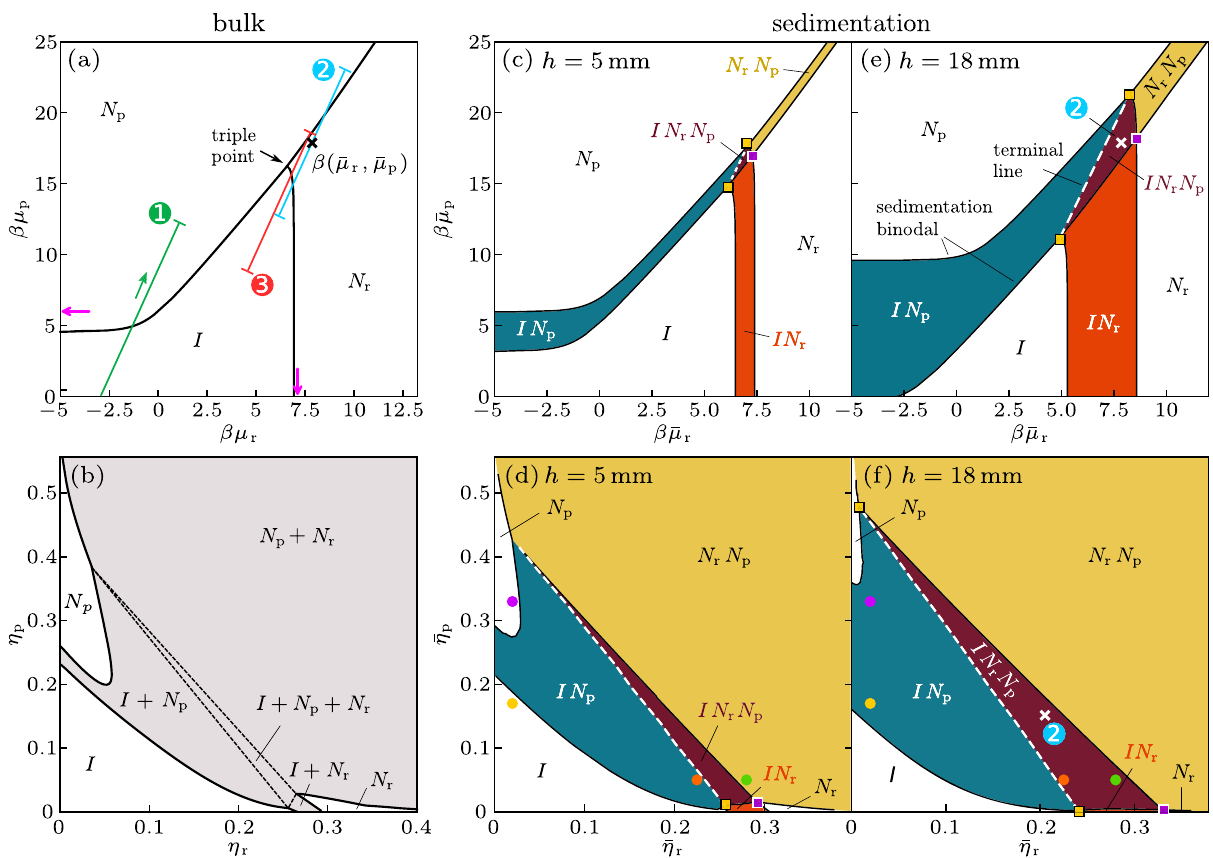
Fig. 4 Bulk and stacking diagrams. Bulk phase diagram in the plane of chemical potentials of rods μ r and plates μ p ( a ) and also in the plane of packing fractions of rods η r and plates η p ( b ). The chemical potentials are scaled with the inverse temperature β = 1/( k B T ). Solid lines are the binodals. The stable phases are isotropic ( I ), nematic plate-rich ( N p ), and nematic rod-rich ( N r ). The violet arrows in ( a ) mark the I − N p and I − N r transitions of pure systems of plates (horizontal arrow) and rods (vertical) obtained by simulations 46 – 48 . The line segments are the sedimentation paths of samples 1, 2, and 3. The green arrow illustrates the direction of the paths from top to bottom. The shadow region in ( b ) is the two phase region and the dashed lines are the tie lines of the triple point. Stacking diagrams for heights h = 5 mm ( c , d ) and 18 mm ( e , f ) in the plane of average chemical potentials of the sedimentation paths for rods (cid:1) μ and plates (cid:1) μ ( c , e ) and average packing fractions of rods (cid:1) η and of plates (cid:1) η in the samples ( d , f ). Black solid (white dashed) lines are sedimentation r p r p binodals (terminal lines). Each stacking sequence is denoted from top to bottom and colored differently (except for the white regions that represent sequences with only one layer). The midpoint of the path for sample 2 is marked with a black cross in ( a ). The position of this sample is also marked in the stacking diagrams with crosses in ( e ) and ( f ). The colored squares indicate the points at which four stacking sequences meet due to the crossing between two sedimentation binodals (violet squares) or the intersection of sedimentation binodals and a terminal line (yellow squares). The colored circles in ( d ) and ( f ) mark samples with the same colloidal packing fractions in both stacking